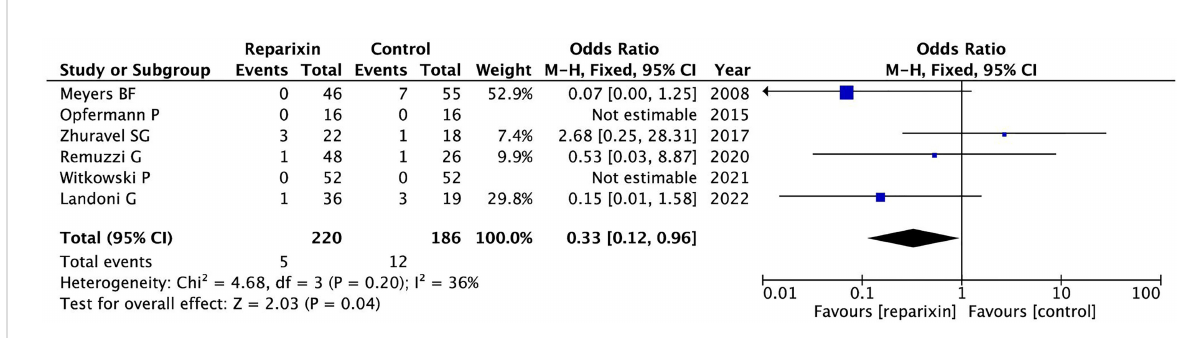
FIGURE 1 Forest plot of the effect of reparixin on mortality according to the six included randomized